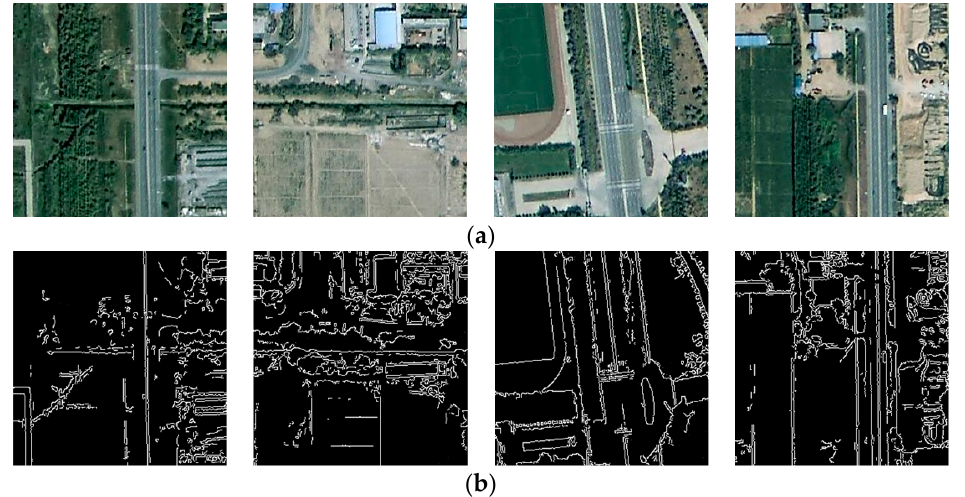
Figure 8. Examples of the training images: ( a ) Examples of original HRRS images, ( b ) corresponding images of robust edge feature.